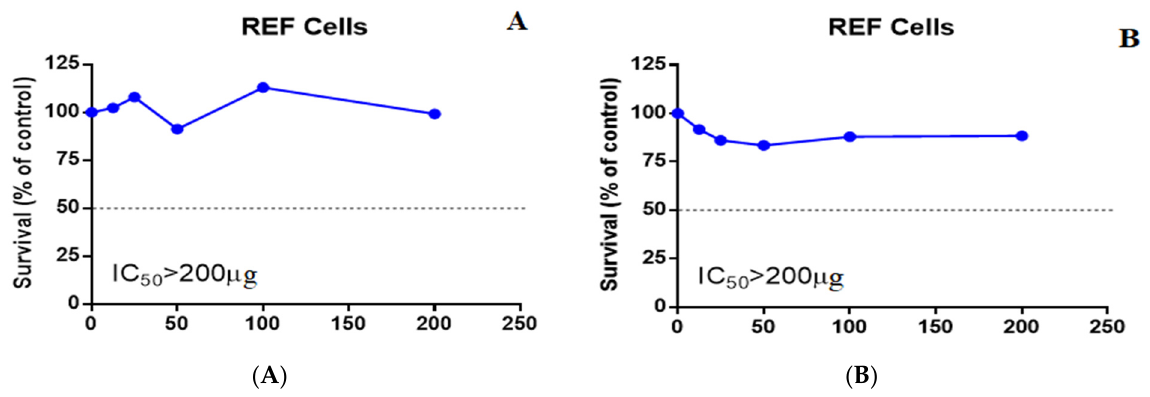
Figure 4. In vitro cytotoxicity of the R. officinalis extracted on REF cell line ( A ): DES2: Tailor, ( B ): DES3: CHGl.